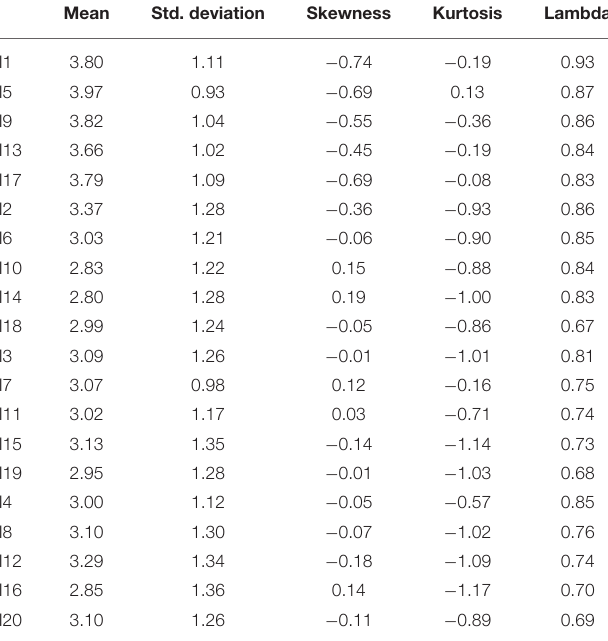
TABLE 1 | Descriptive statistics, normality coefficients and Lambda factor loadings of the PE-SPQ.